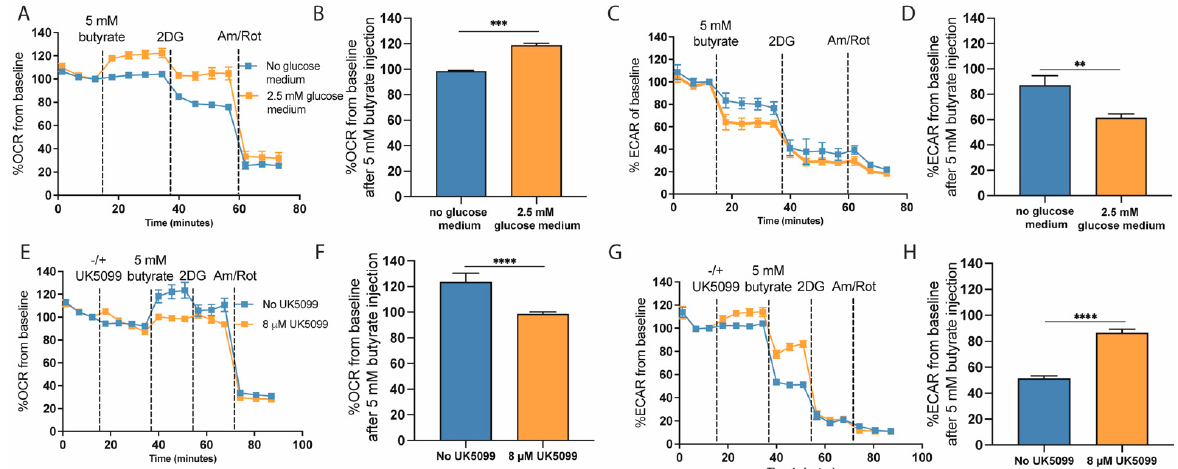
Figure 5. The altered response to acute butyrate exposure as a consequence of glycolysis inhibition in HT29 cells. ( A , B ) OCR response following butyrate exposure in absence or presence of 2.5 mM glucose in the medium (representative experiment of N = 2 independent experiments consisting of n = 6 wells). ( C , D ). ECAR response following butyrate exposure in absence or presence of 2.5 mM glucose in the medium (representative experiment of N = 2 independent experiments consisting of n = 6 wells). ( E , F ) OCR response upon inhibition of pyruvate oxidation using 8 µM UK5099 in the presence of 2.5 mM glucose (representative experiment of N = 3 independent experiments consisting of n = 13–15 wells). ( G , H ) ECAR response upon inhibition of pyruvate oxidation using 8 µM UK5099 (representative experiment of N = 3 independent experiments consisting of n = 13–15 wells; significance was determined for one representative experiment using repeated-measures ANOVA followed by Bonferroni’s post-hoc analysis. p < 0.01 = **, p < 0.001 = ***, p < 0.0001 = ****).